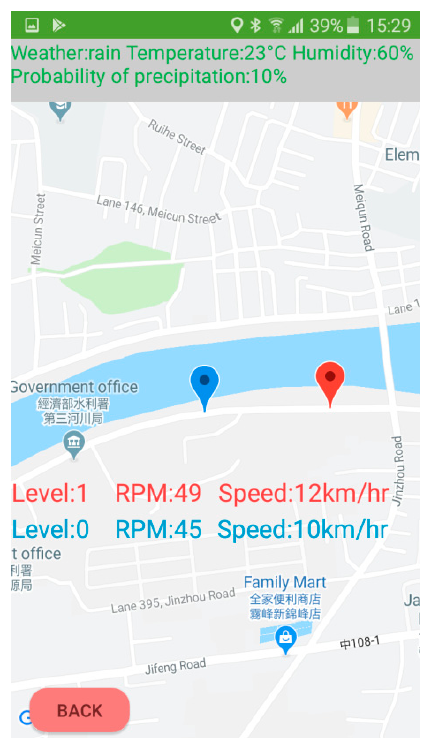
Figure 11. A sample map of the APP for a cyclist.